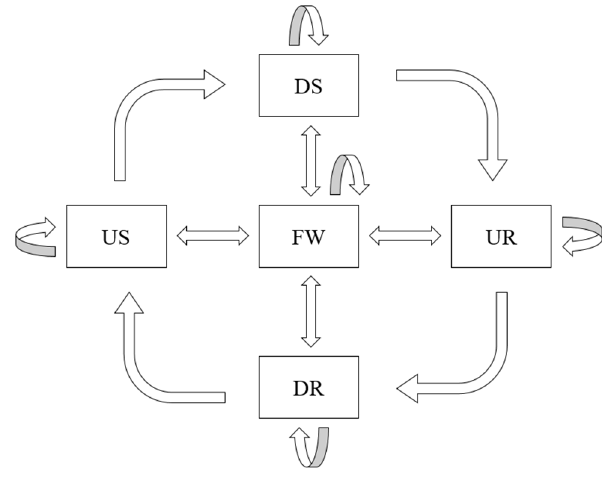
Figure 5. Finite state machine transition diagram of locomotion modes.